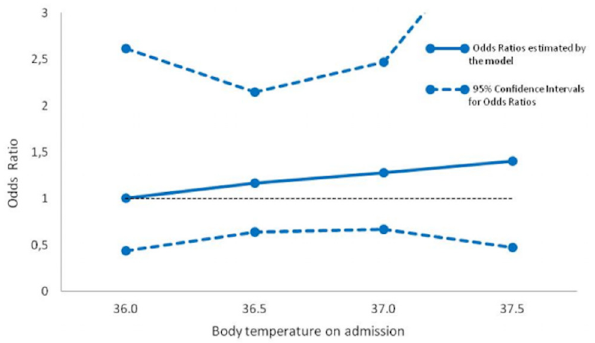
Fig 1. Odds ratios for the relation between body temperature on admission and